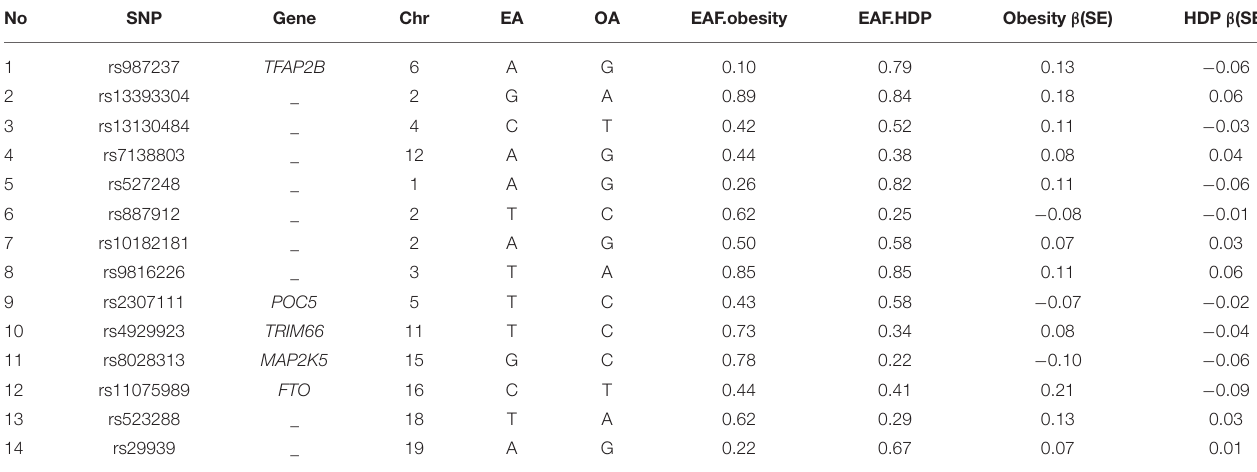
TABLE 1 | List of genetic instruments for obesity and log odds ratios of hypertension disorders in pregnancy risk by each instrumental SNP (GWAS significance with P < 5 × 10 − 8 and linkage disequilibrium threshold with R 2 < 0.001).